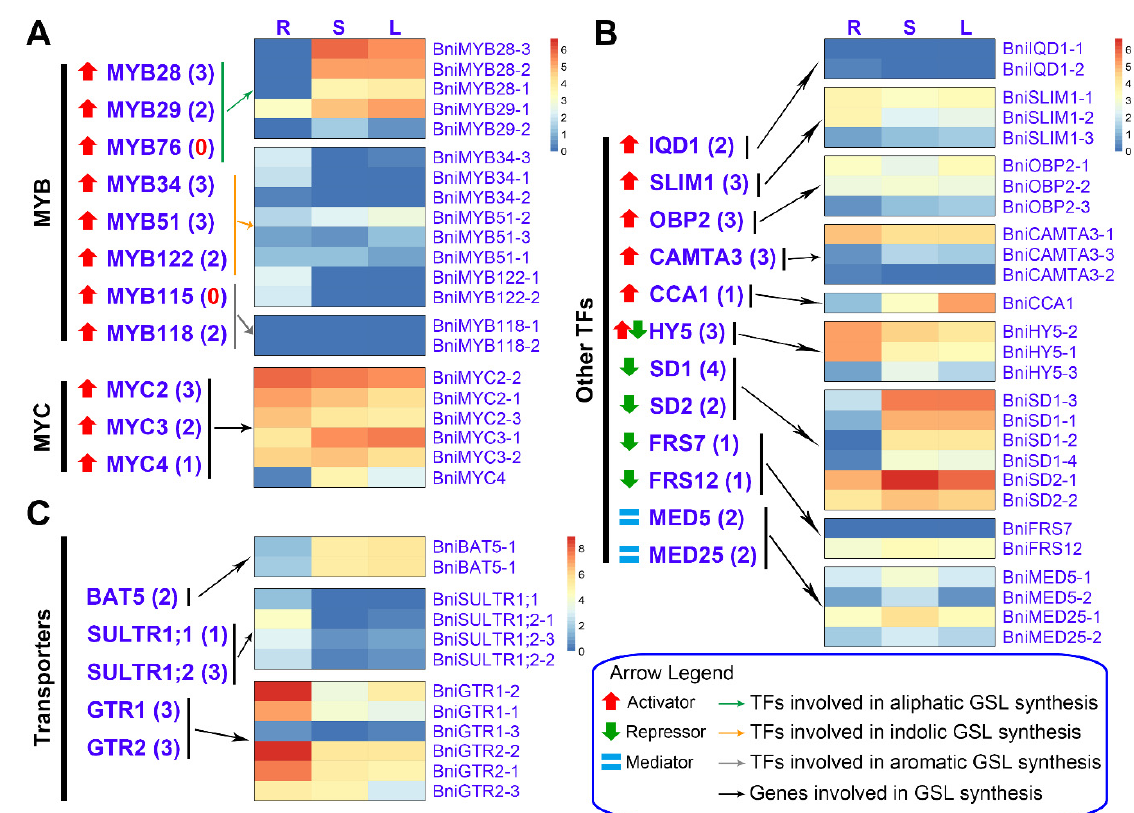
Figure 3. Heatmap of transcription factor (TFs) genes and transporter genes involved in GSL biosynthesis. Expression analysis of BniMYBs ( A ) and other TFs ( B ) involved in GSL biosynthesis. ( C ) Expression analysis of BniGSLs encoding transporters involved in GSL transportation. The number in parentheses represents the copy number of the gene. Abbreviations: BAT5, probable sodium/metabolite cotransporter BASS5; CAMTA3, calmodulin-binding transcription activator 3; CCA1, circadian clock-associated 1; FRS, Far1 related sequence; GTR, GSL transporter; HY5, long hypocotyl 5; IQD1, IQ domain 1; L, leaf; MED, mediator subunit; OBP2, UAS-tagged root patterning 3; R, root; S; stem; SD, protein sulfur deficiency-induced; SLIM1, sulfur limitation 1; SULTR, sulfate transporter.